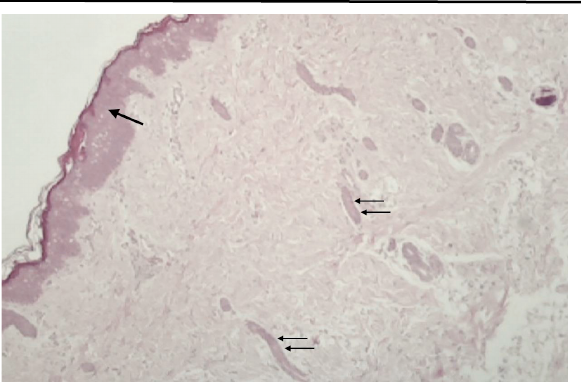
Figure 3 - Dermoid tumor demonstrating keratinized squamous stratified epithelium (Thick black arrow) and eccrine glands (double black arrows).